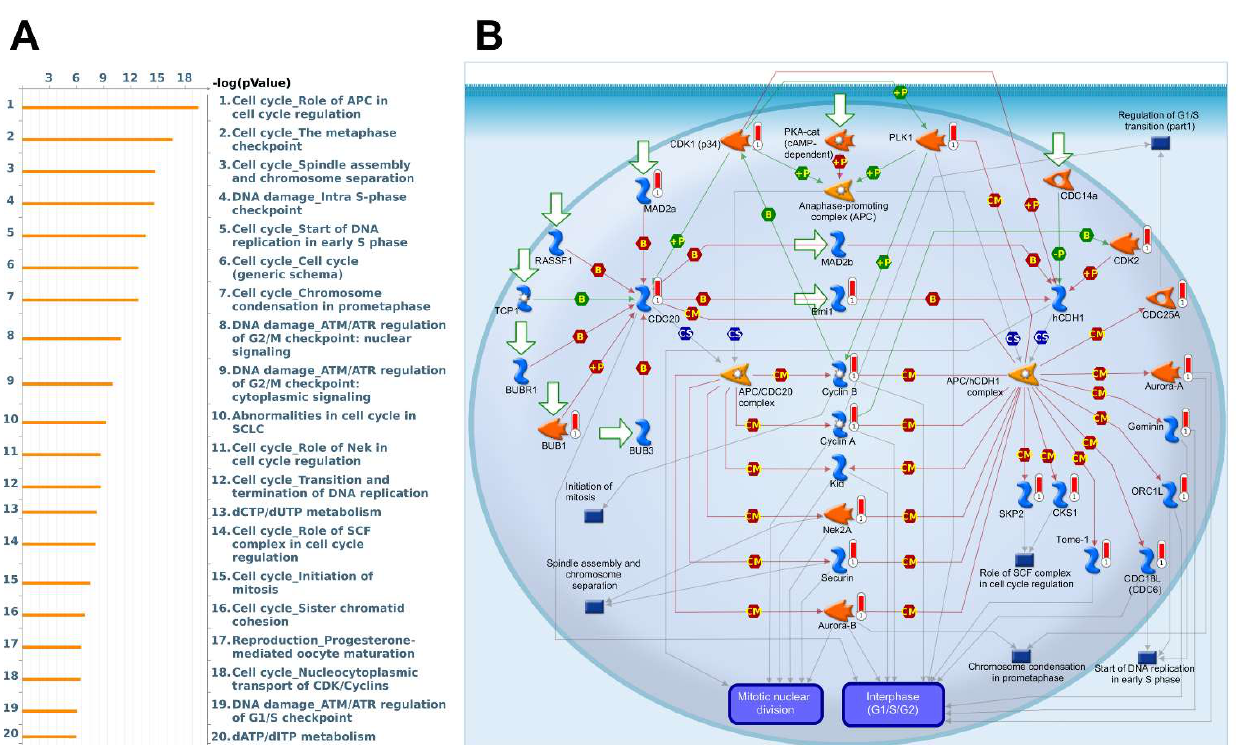
Figure 8. Enrichment pathway analysis of GPSM2 co-expressed genes in breast cancer database (MetaCore). ( A ) Pathway analysis. Potential gene networks and pathways affected by co-expressed genes (right column) and respective log p value (left column). ( B ) Biological process analysis. Symbols represent proteins. Arrows depict protein interactions (green, activation; red, inhibition). Thermometer-like histograms indicate microarray gene expression (blue, down-regulation; red, up-regulation).